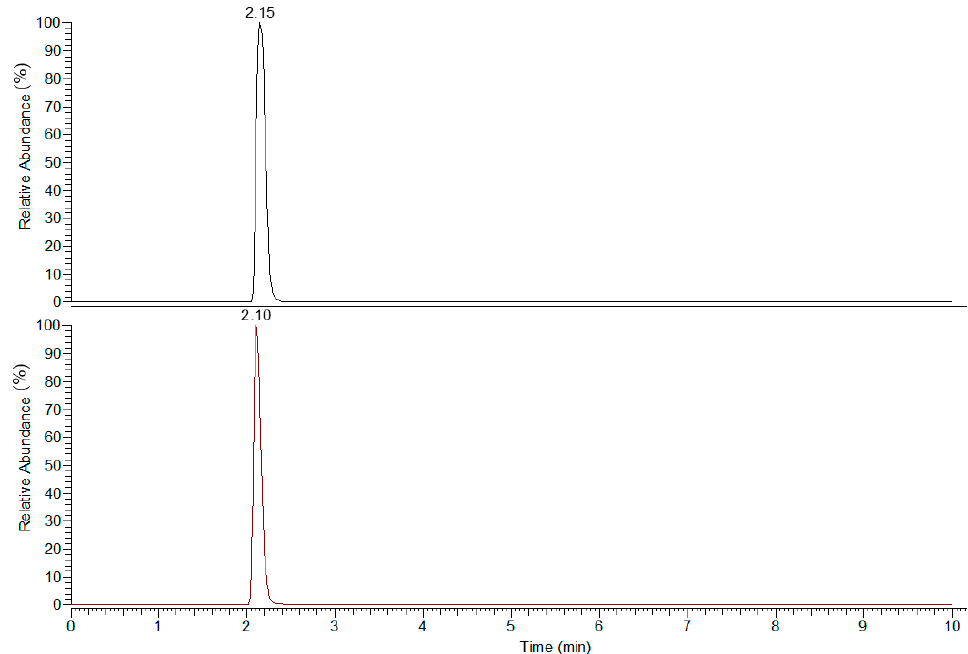
Figure 1. Extracted ion chromatogram of vicine and convicine.